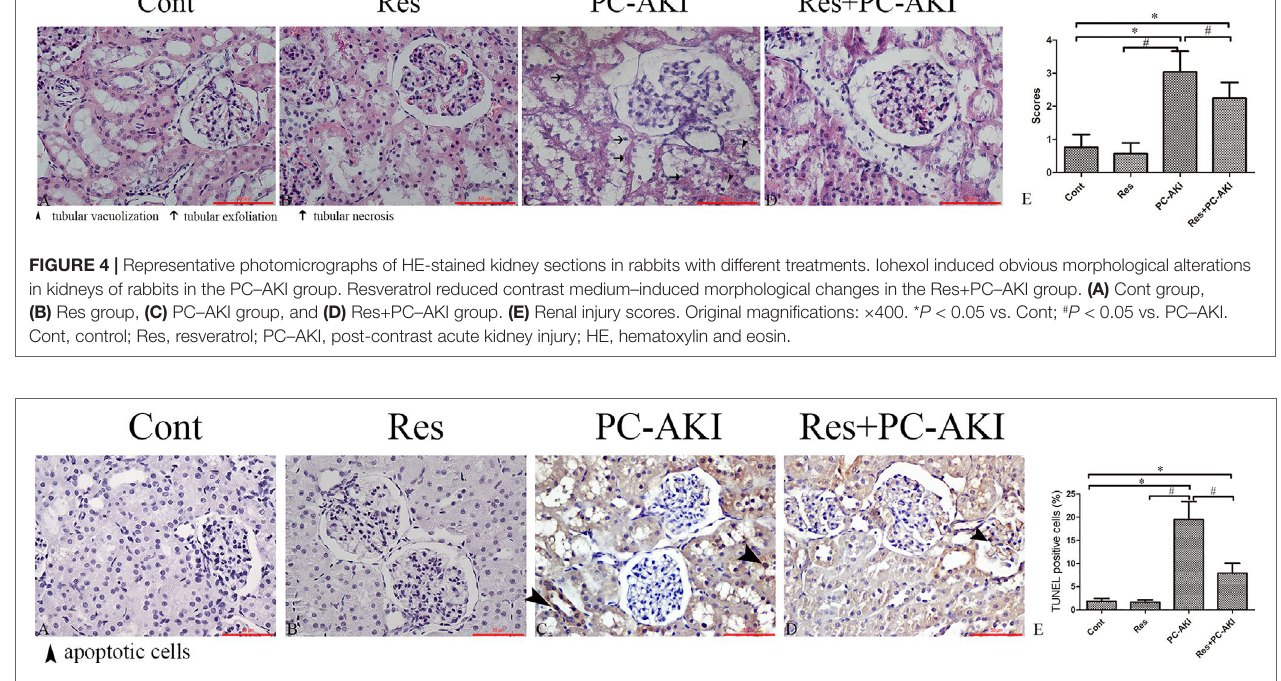
FIGURE 5 | Representative images of transferase dUTP nick-end labeling (TUNEL) staining for rabbits with different treatments. (A–D) TUNEL staining (E) Quantitative analysis of TUNEL-positive cells. A significant increase in TUNEL-positive cells was observed in the kidneys of rabbits with DN 24 h after contrast medium injection, whereas resveratrol inhibited renal tubular cell apoptosis. Original magnifications: ×400. * P < 0.05 vs. Cont; # P < 0.05 vs. PC–AKI. TUNEL, terminal deoxynucleotidyl transferase dUTP nick-end labeling; DN, diabetic nephropathy; Cont, control; Res, resveratrol; PC–AKI, post-contrast acute kidney